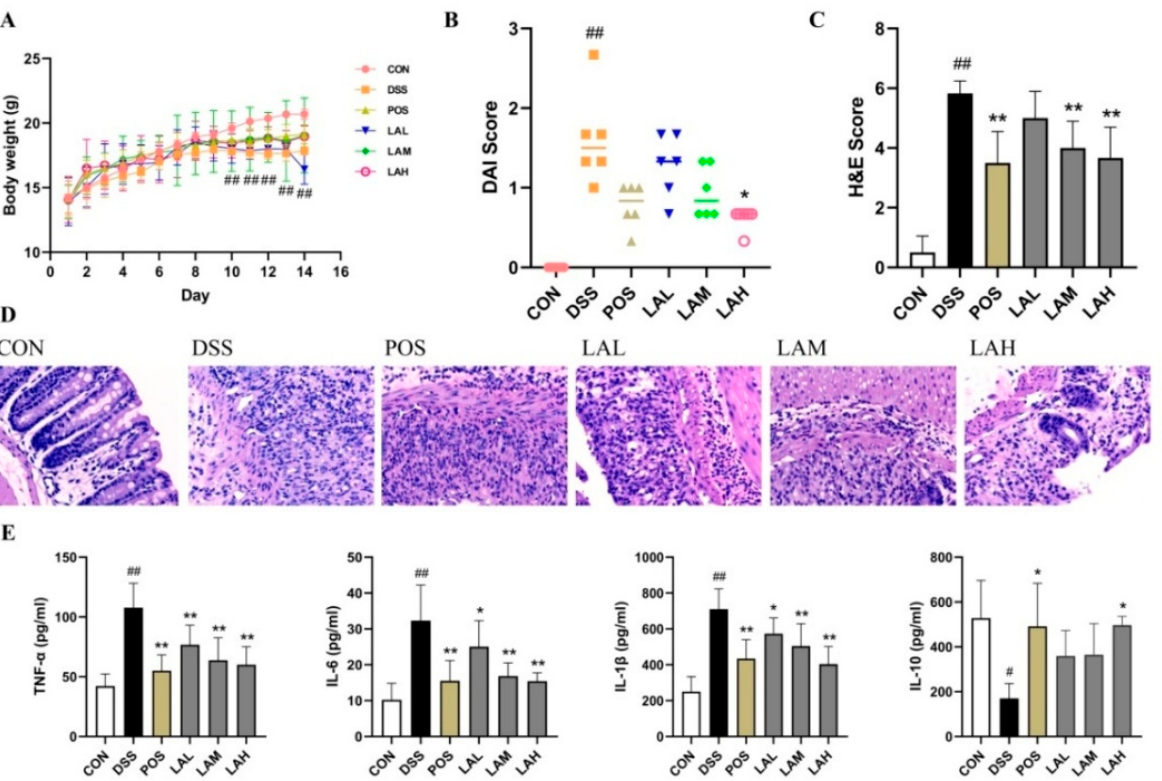
Figure 1. LA protected mice against dextran sodium sulfate (DSS)-induced ulcerative colitis (UC) and attenuated colonic inflammation. ( A ) Body weight of mice over the course of 14 days. ( B ) Disease activity index (DAI) score of each mouse on day 14. ( C ) Hematoxylin and eosin (H&E) scores. ( D ) Photomicrographs of H&E staining (200×). ( E ) Levels of TNF- α , IL-6, IL-1 β , and IL-10 in colon tissue. Data are expressed as mean ±SD ( n = 6); # p < 0.05 and ## p < 0.01 vs. CON, * p < 0.05 and ** p < 0.01 vs. DSS.